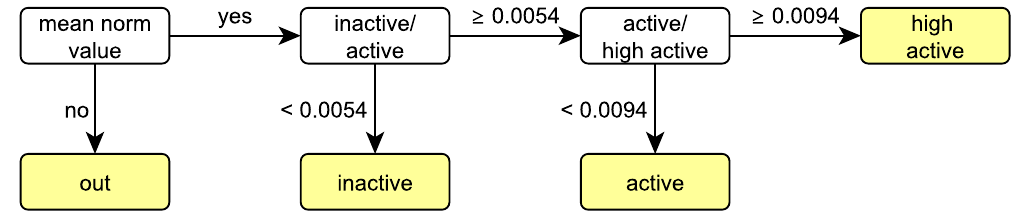
Figure 8. Decision tree for the activity levels using thresholds for the mean norm